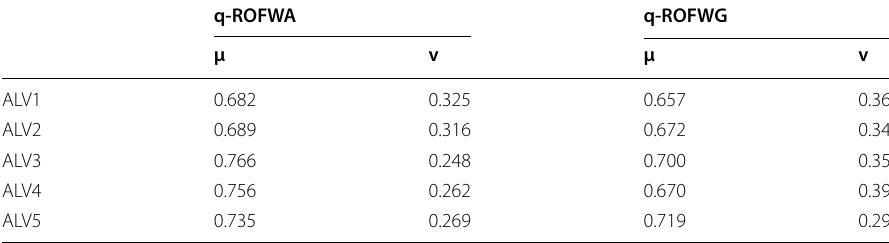
Table 12 Weighted average values of